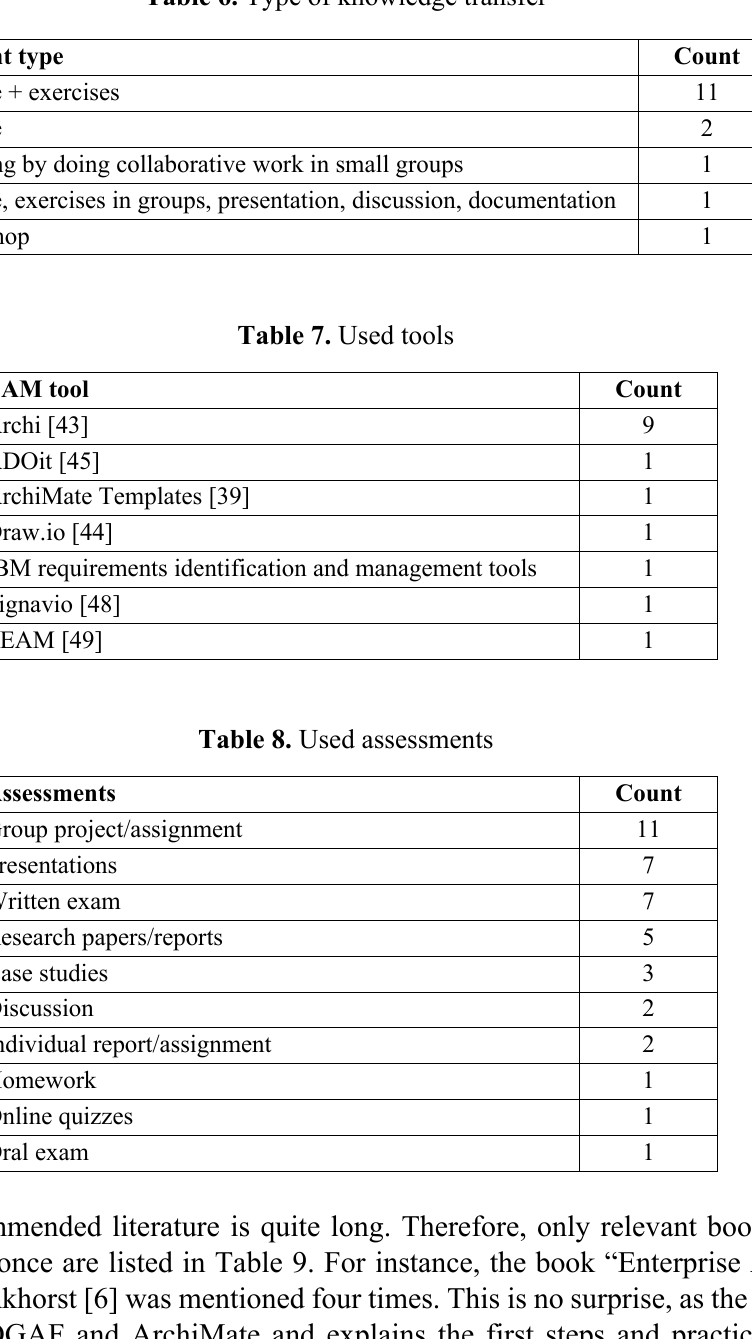
Table 6. Type of knowledge transfer